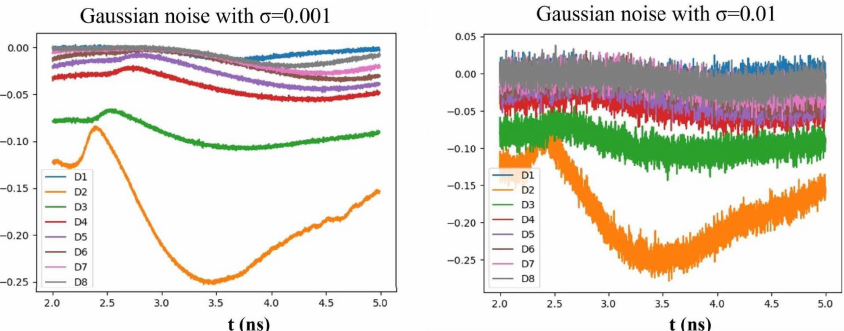
Figure 3. Datasets with noises: the left panel shows training data with Gaussian noises whose standard deviation is σ = 0.001, and the right panel is test data with Gaussian noises of σ =